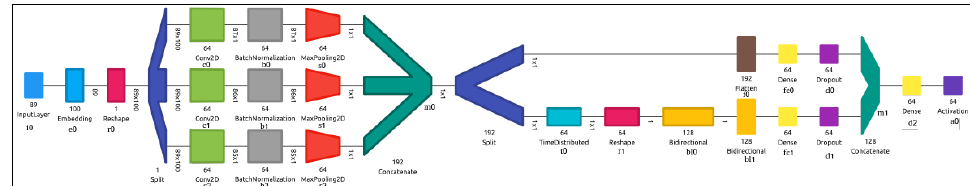
Figure 2. CNN LSTM network.